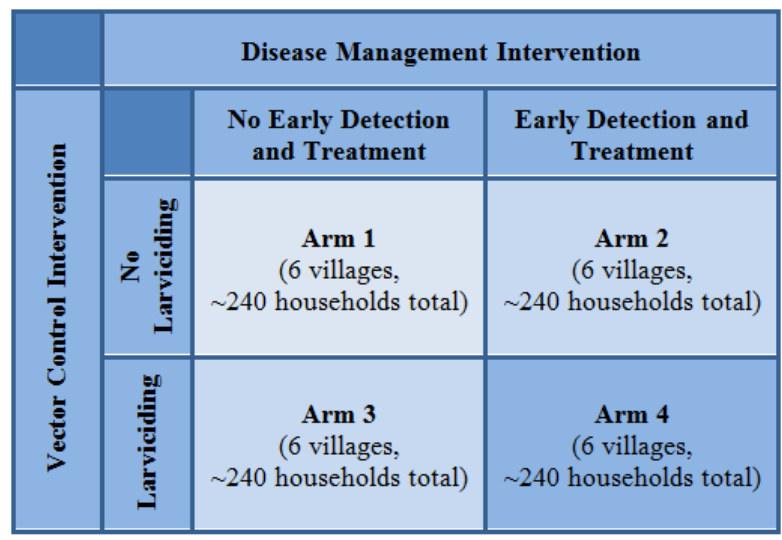
Figure 2. Factorial study